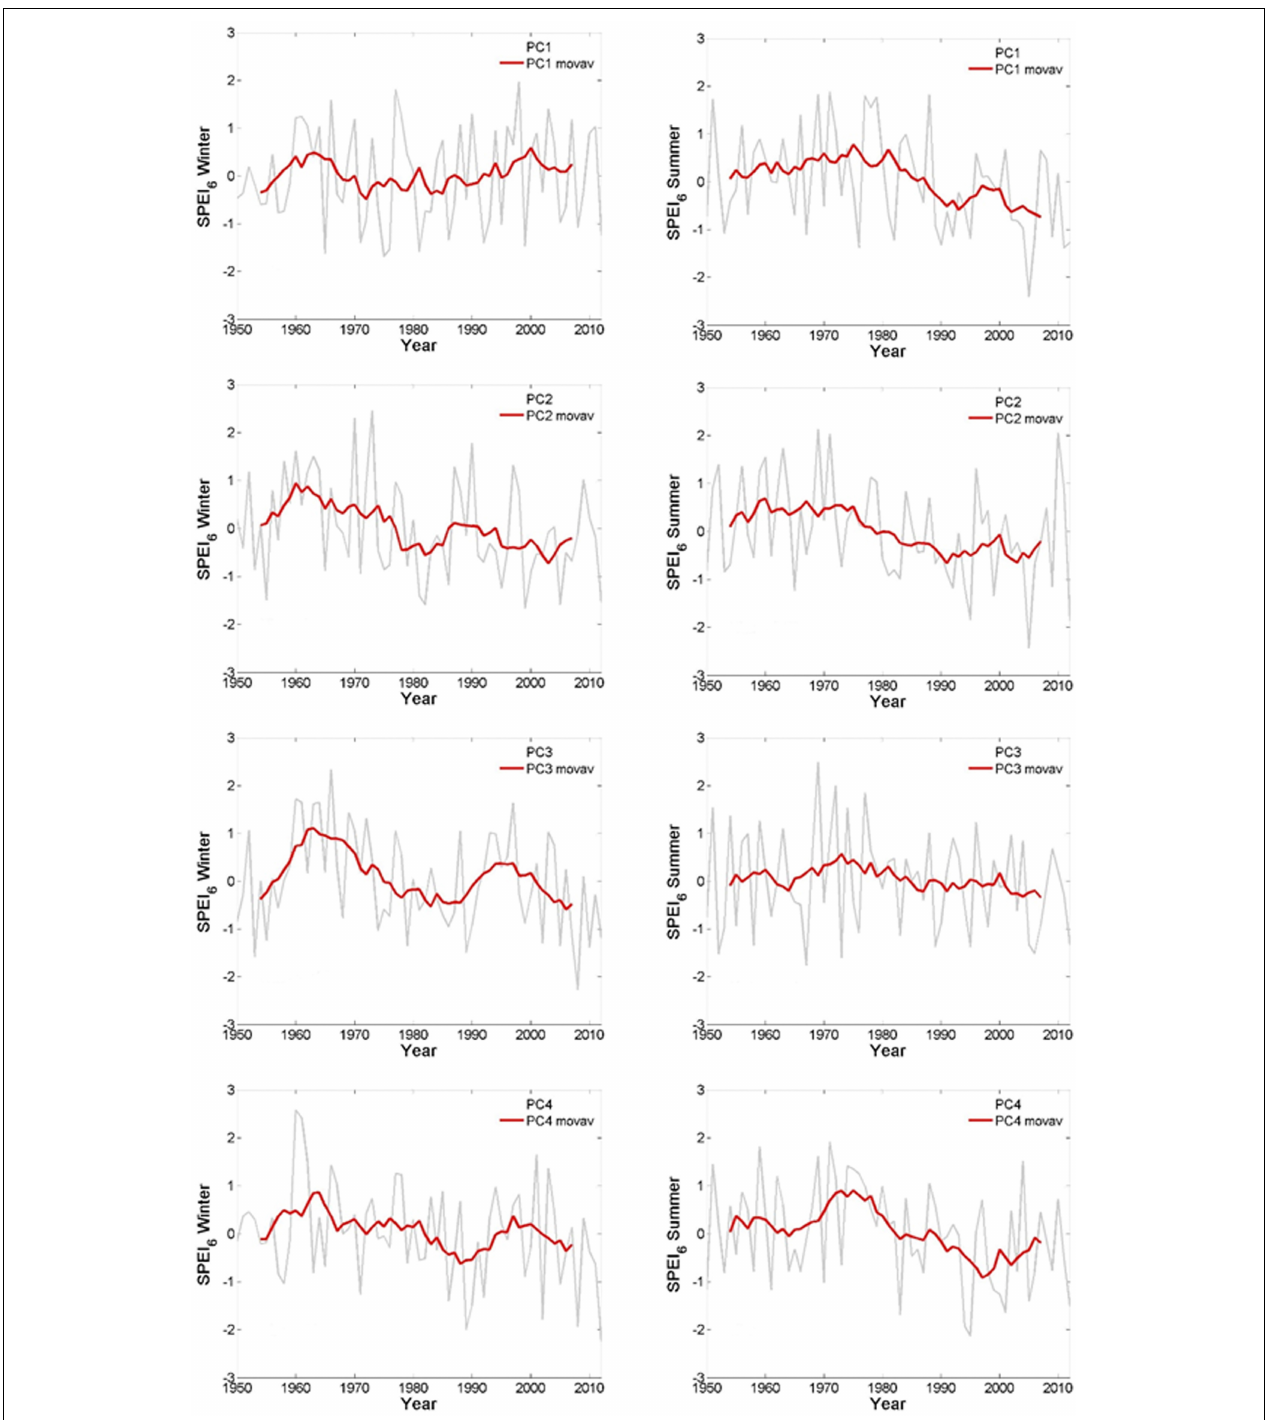
FIGURE 6 | Evolution of the first four principal components (PC1-PC4) in the winter (left panel) and in the summer (right panel). Red line indicates a moving average of 9 years for each PC.